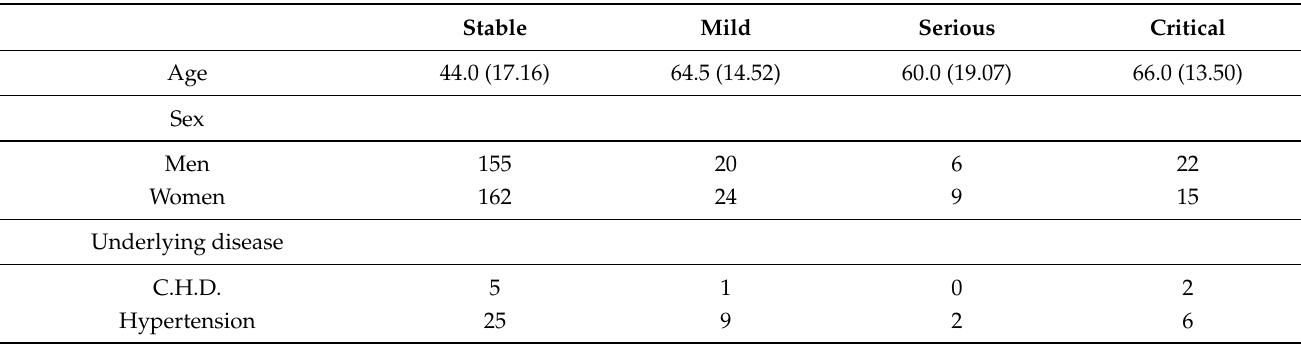
Table 2. The distribution of various features according to Severity class based on the amount of oxygen consumed. The number of patients comorbidities in each class is indicated as such, while the median values of the test results and the interquartile range (in parentheses) are presented for each